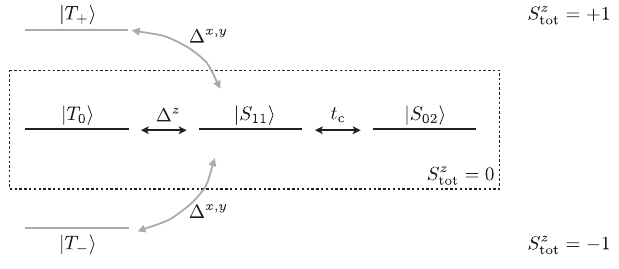
≠ 1 can be tuned off tot